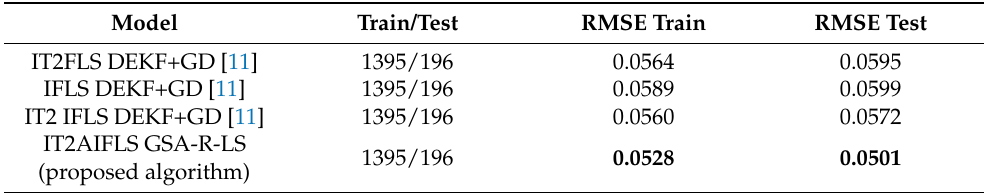
Table 3. Performance comparison of the proposed hybrid algorithm for the IT2AIFLS on the Poland electrical load dataset in terms of RMSEs. The best results are highlighted in